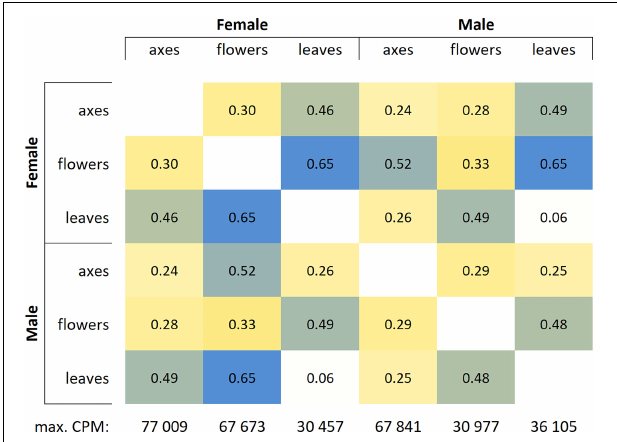
FIGURE 1 | Distance matrix for gene expression profiles in leaves, catkin axes, and flowers of male and female Populus × sibirica plants. Transcriptome sequencing data; genes with CPM (counts per million) > 16 were taken into account; max. CPM, maximum CPM among all genes.